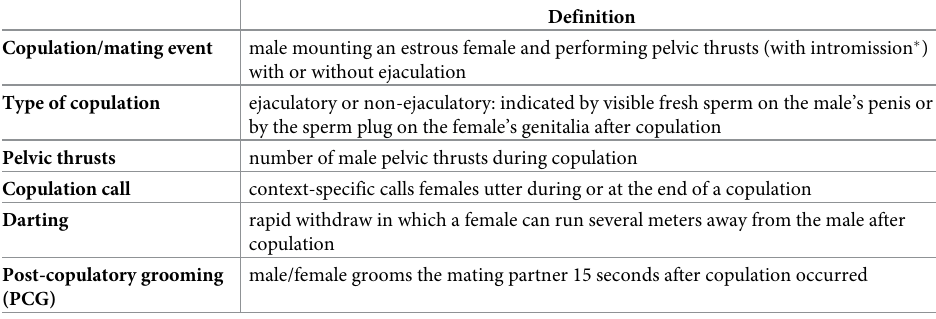
Table 1. Definition of behavioral